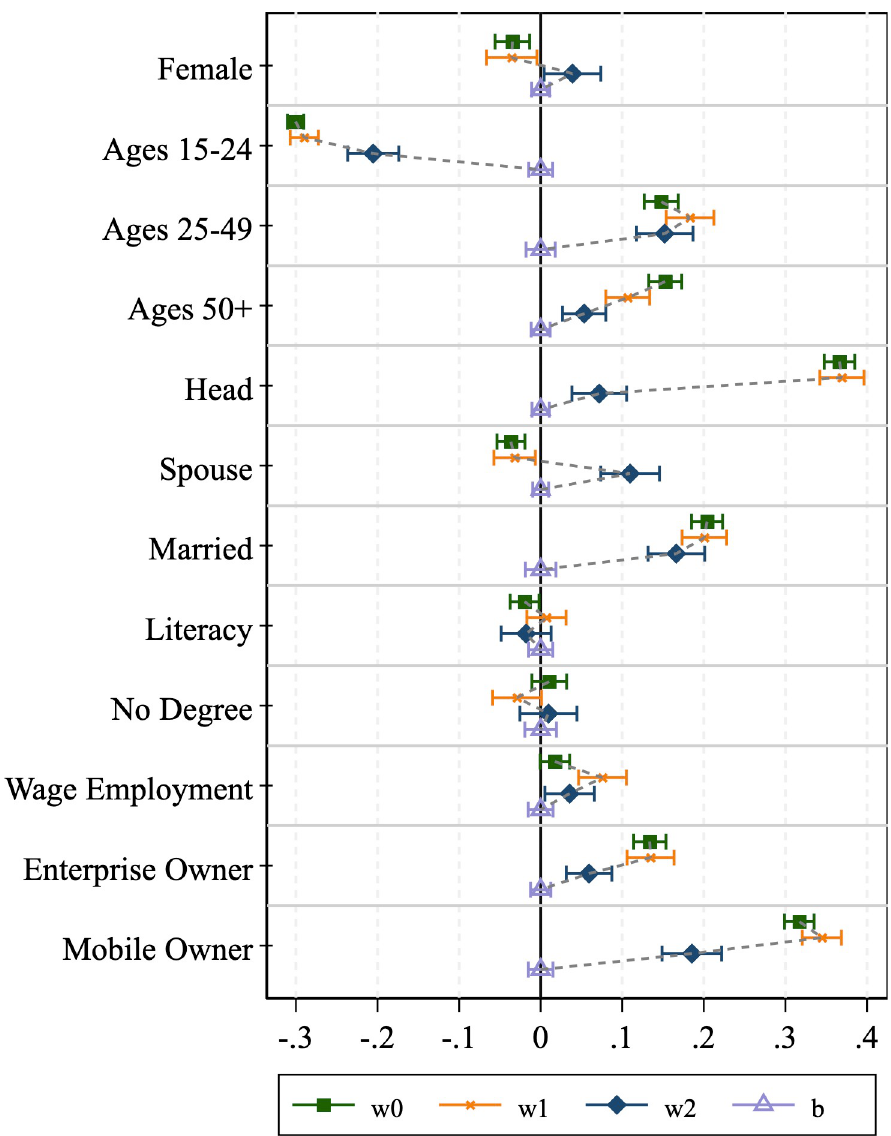
Fig 4. Graphical inspection of bias adjustment,